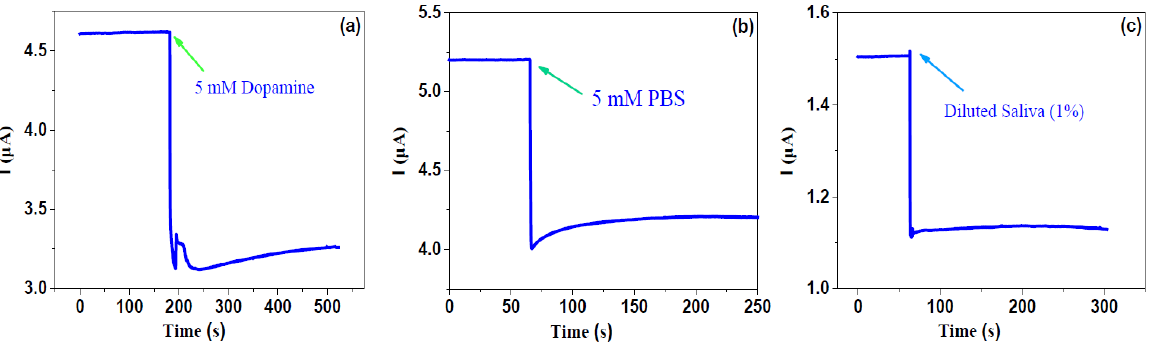
Figure 3. Response for 5 mM PBS, 5 mM dopamine and 1% diluted saliva solution.